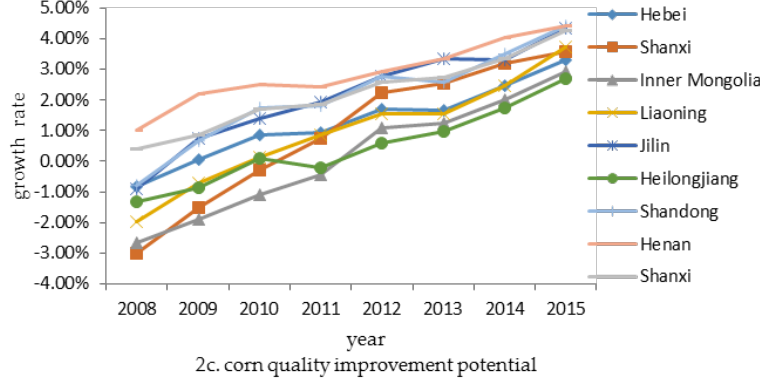
Figure 2. Trends of grain quality improvement potential in all samples.